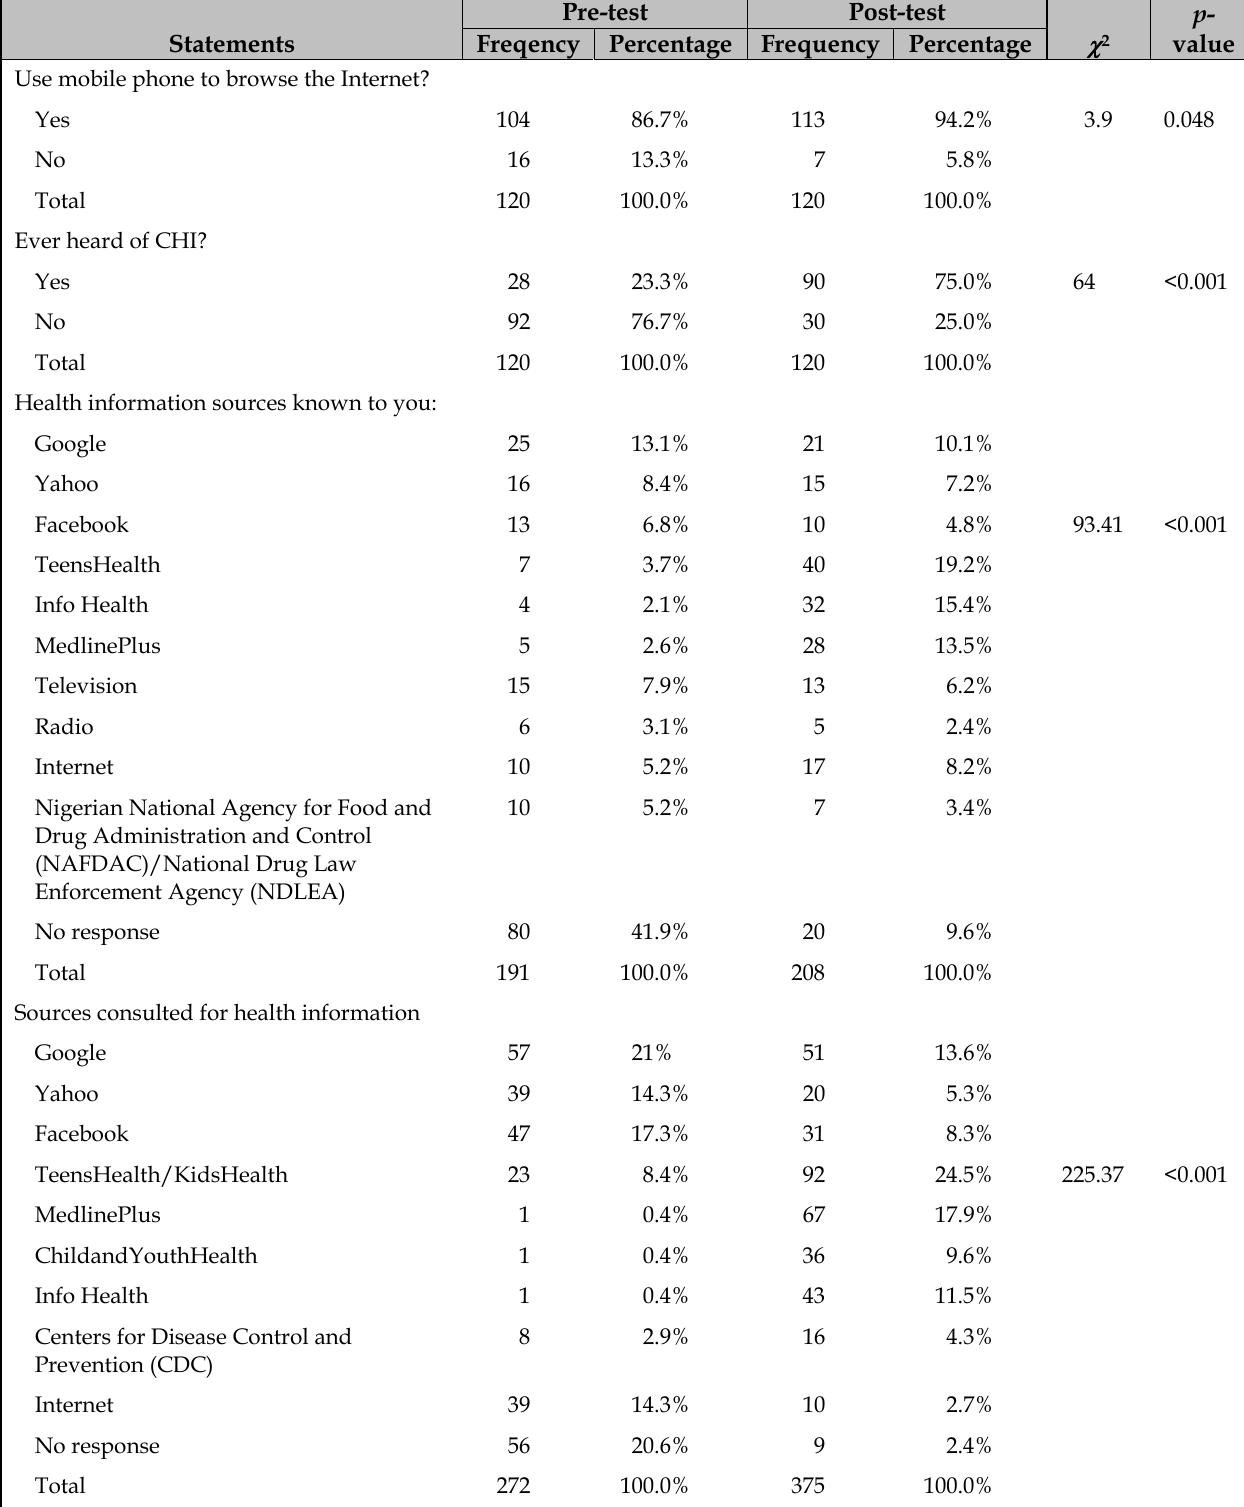
Table 2 Percentage of PEs who were aware of consumer health information (CHI) and CHI resources